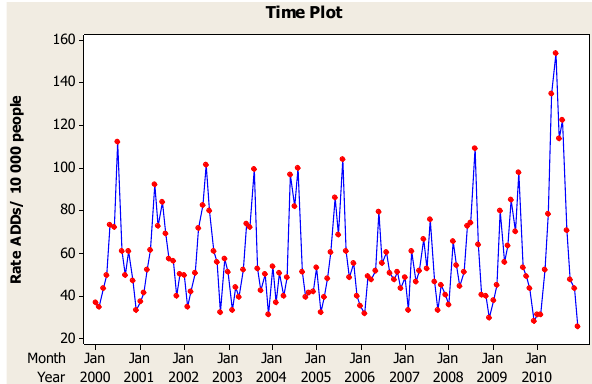
Figure 3. Time Plot rate